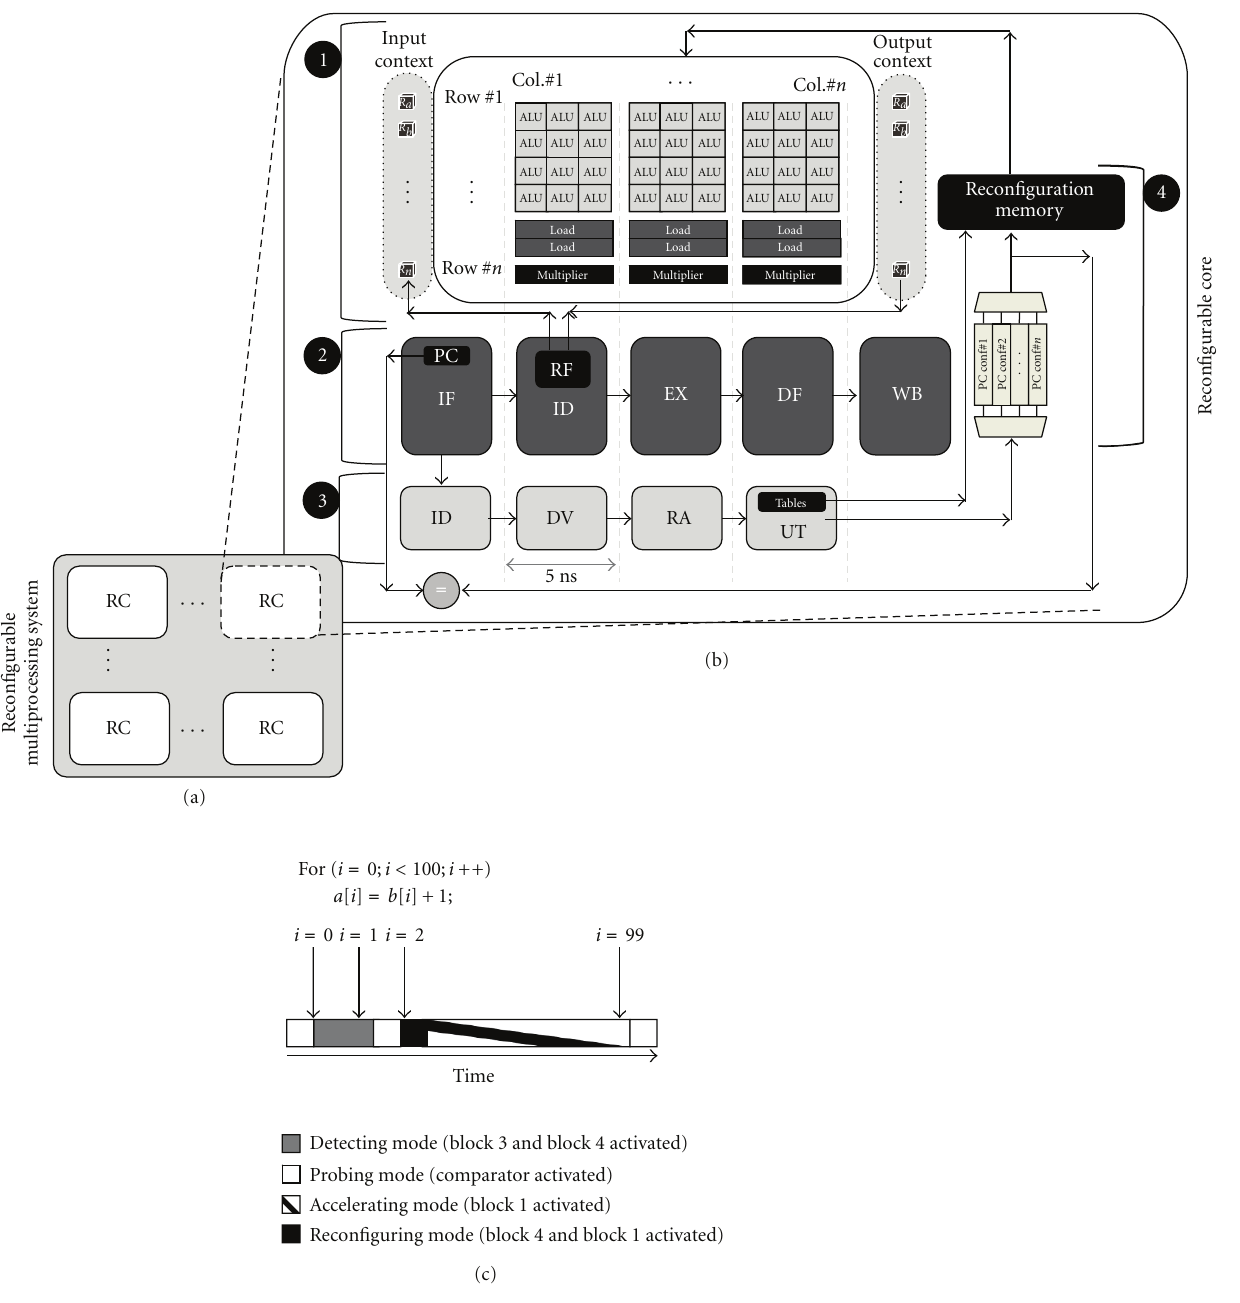
Figure 2: (a) Multiprocessing system. (b) Reconfigurable core. (c) Example of a loop